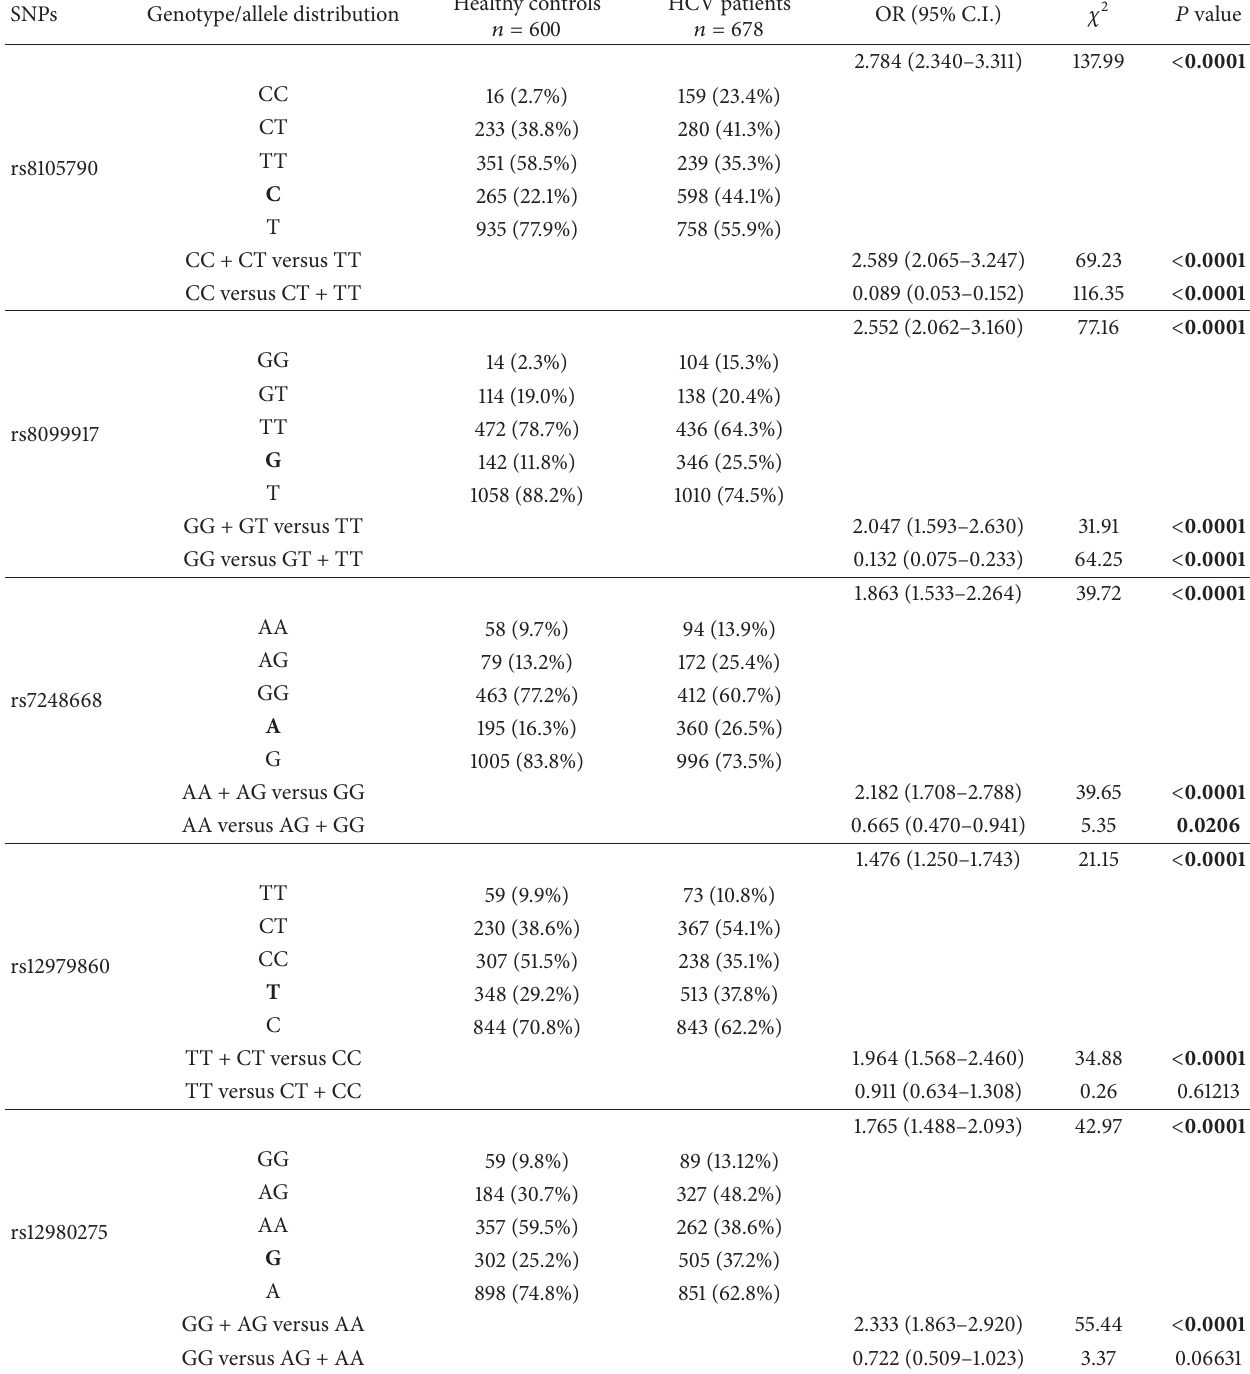
Table 2: Genotypic distribution for IL-28B gene polymorphism when patient group (groups “1+2+3”) was compared to control group.